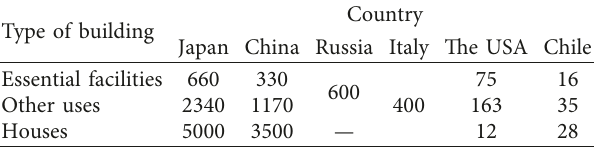
Table 1: Number of buildings with base